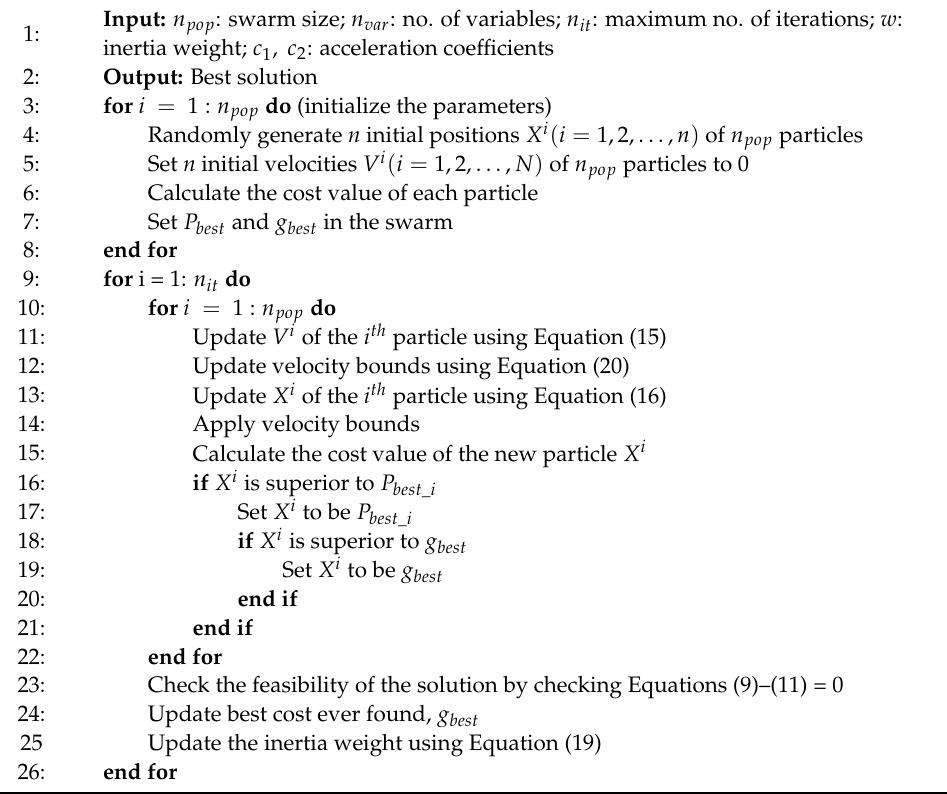
Algorithm 1. Particle swarm optimization.